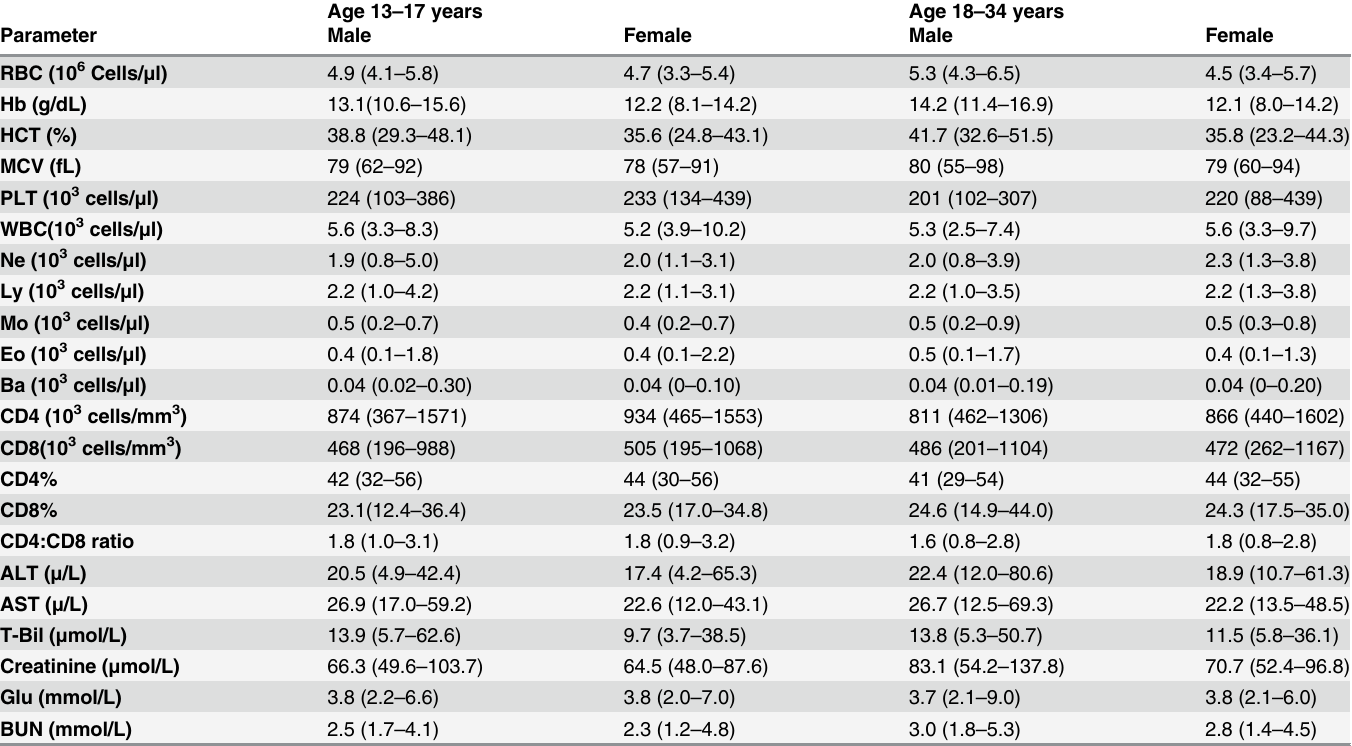
Table 1. Hematological, immunologic and biochemistry reference intervals (median and 95 th -percentile) stratified by age and gender from a 13 – 34 years old cohort in rural western Kenya (2003 – 2005)